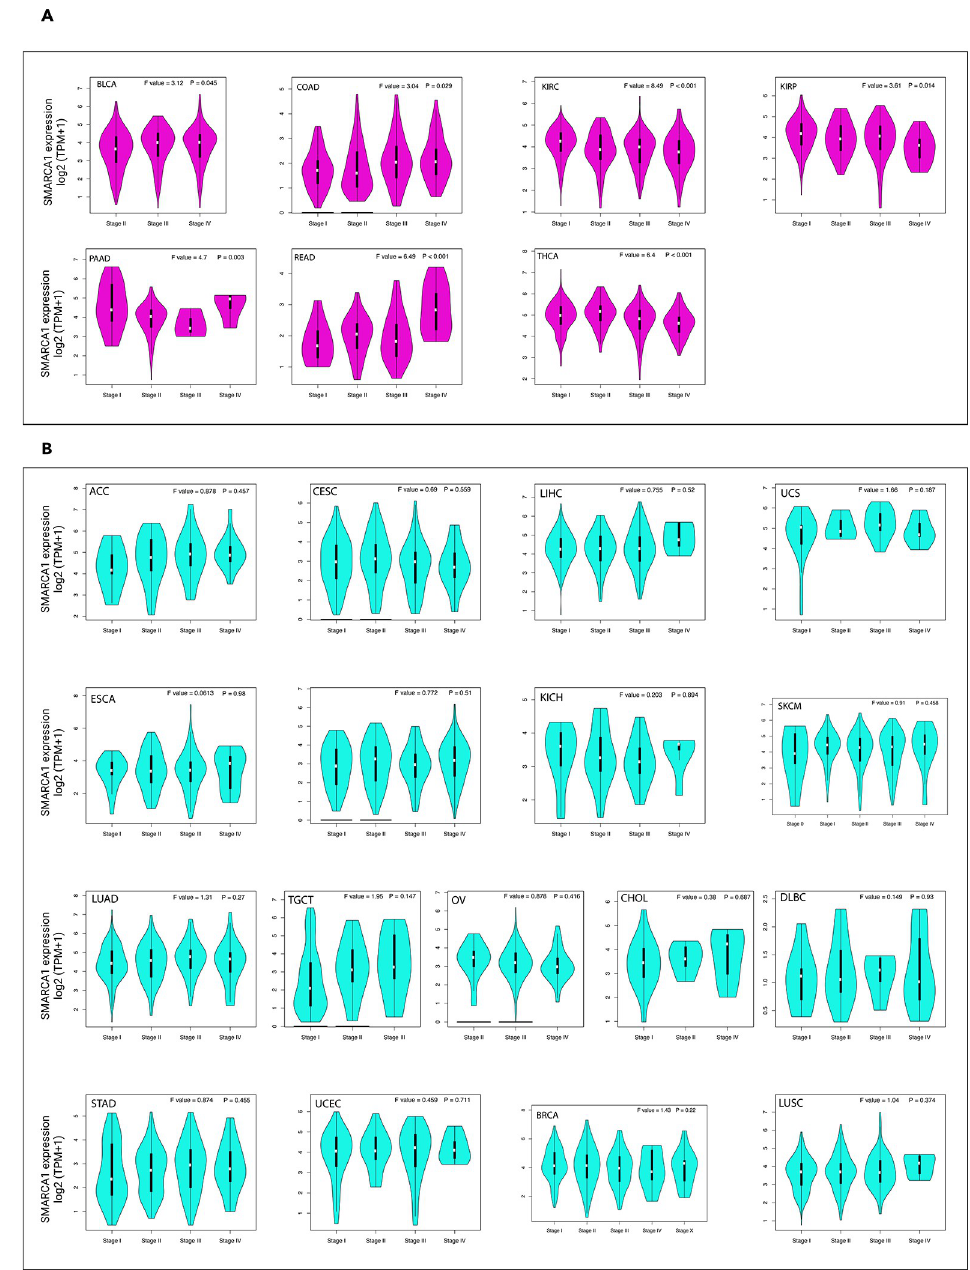
Fig 4. Expression of SMARCA1 gene in different pathological stages of diverse cancers in TCGA. (A) Expression difference in BLCA, COAD, KIRC, KIRP, PAAD, READ and THCA; (B) Expression difference in ACC, BRCA, CESC, CHOL, DLBC, ESCA, HNSC, KICH, LIHC, LUAD, LUSC, OV, SKCM, STAD, TGCT, UCEC and UCS. Log 2 (TPM+1) was applied for log-scale, � P < 0.05, �� P < 0.01, ��� P < 0.001. We also investigated the relationship between SMARCA1 expression and different patho- logical stages of various cancers via the “pathological stage plot” module of GEPIA2. Signifi- cant differences were observed in BLCA, COAD, KIRP, KIRC, PAAD, READ and THCA (all P < 0.05) (Fig 4A) but not in others (Fig 4B).